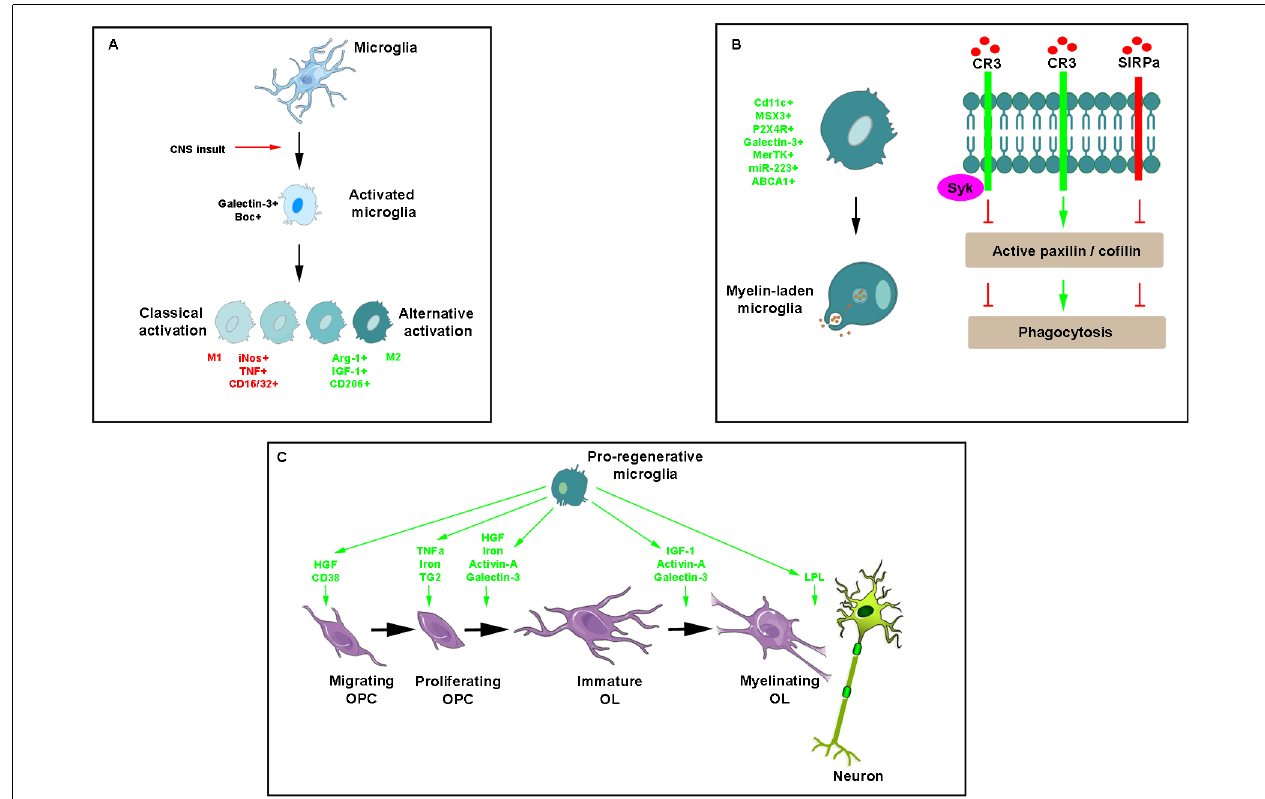
FIGURE 3 | Key effects of microglia/macrophages during myelin repair. (A) Illustration of morphological modifications of ramified microglia/macrophages, which adopt a rhomboid shape in the presence of any insult and become activated into a classical or alternative manner giving rise to a range of cell phenotypes expressing mostly pro- (red) or anti-inflammatory (green) molecules, respectively. (B) Phagocytosis of myelin debris is a critical activity of microglia/macrophages for promoting myelin regeneration. Phagocytic receptors such as CR3 advance phagocytosis by promoting the activation of paxillin and cofilin whereas the immune inhibitory receptor SIRP α , inhibits phagocytosis by promoting the inactivation of the two. Recruited by CR3, Syk downregulates CR3-mediated myelin phagocytosis protecting phagocytes from excessive phagocytosis during prolonged exposure to debris. (C) Pro-regenerative microglia secrete a range of molecules intervening at various steps of myelin